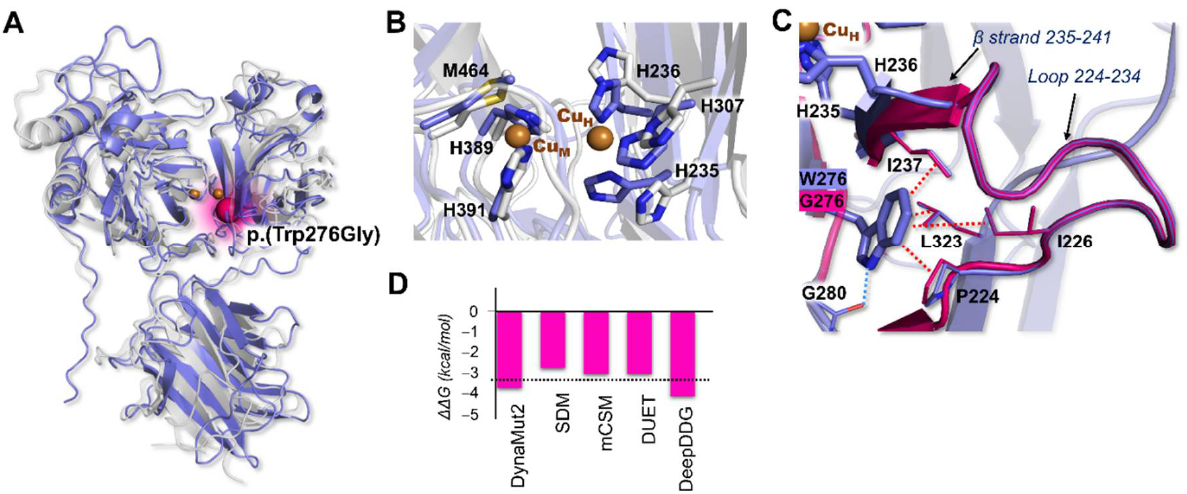
Figure 2. ( A ) 3D model of MOXD1 (in pale blue) superimposed on the crystal structure of hDBH monomer (in grey, PDB ID: 4ZEL). The N- and C-terminal portions (1–22 and 582–613, respectively) of the MOXD1 model were not considered, since these regions of the AlphaFold model were characterized by low (70 < pLDDT < 50) or very low (pLDDT < 50) confidence. The positions of the two copper ions, absent in the predicted model, were modeled to complete the overall architecture of each Type II Cu site. The p.(Trp276Gly) mutation was mapped onto the 3D model as pink spheres; ( B ) Cu H and Cu M sites in MOXD1 (pale blue) and DBH (in grey); ( C ) superimposition of wild-type MOXD1 (in pale blue) and of the p.(Trp276Gly) mutant (in pink) models. In the wild-type, the hydrogen bond between G280 and W276 is highlighted as a dotted light blue line, while hydrophobic contacts with P224, I226, I237, and L323 are shown as dotted red lines; ( D ) predicted ∆∆ G values. The average value obtained for each mutation is indicated by a horizontal black dotted